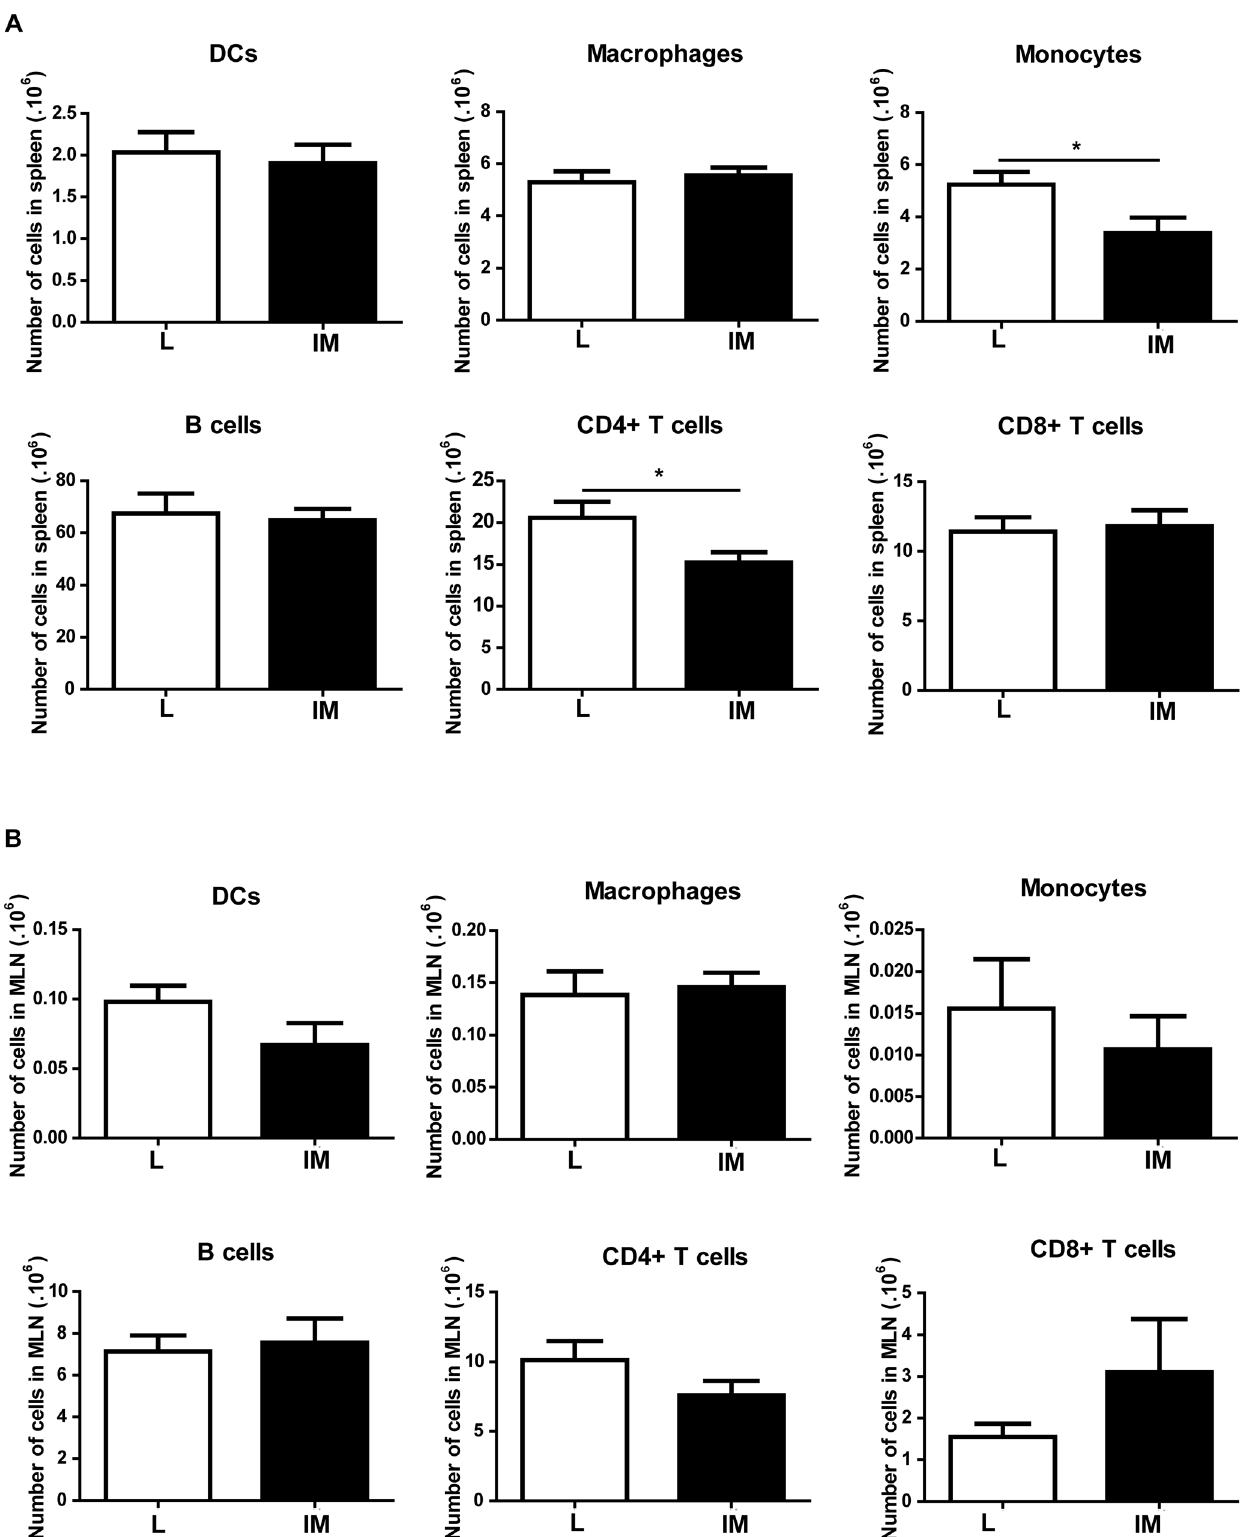
Figure 6. Intestinal Manipulation leads to decreased populations in the spleen but doesn’t affect the MLN. (A). The number of DCs, macrophages, B cells and CD8 T cells is not significantly altered 24 h after IM in the spleen whereas the number of CD4 T cells is significantly decreased. (B). The number of cells of all population measured remains identical in the MLN after L and IM. Data shown are mean 6 SEM of 2 independent experiments (n=8–9 animals per group). p , 0.05 (Student t-test).